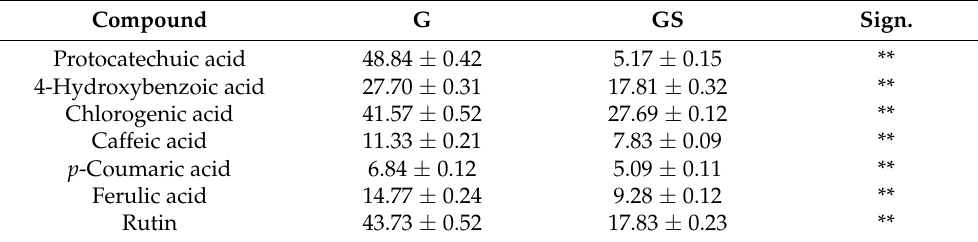
Table 5. UHPLC analysis of selected compounds in freeze-dried goji samples ( µ g/g).